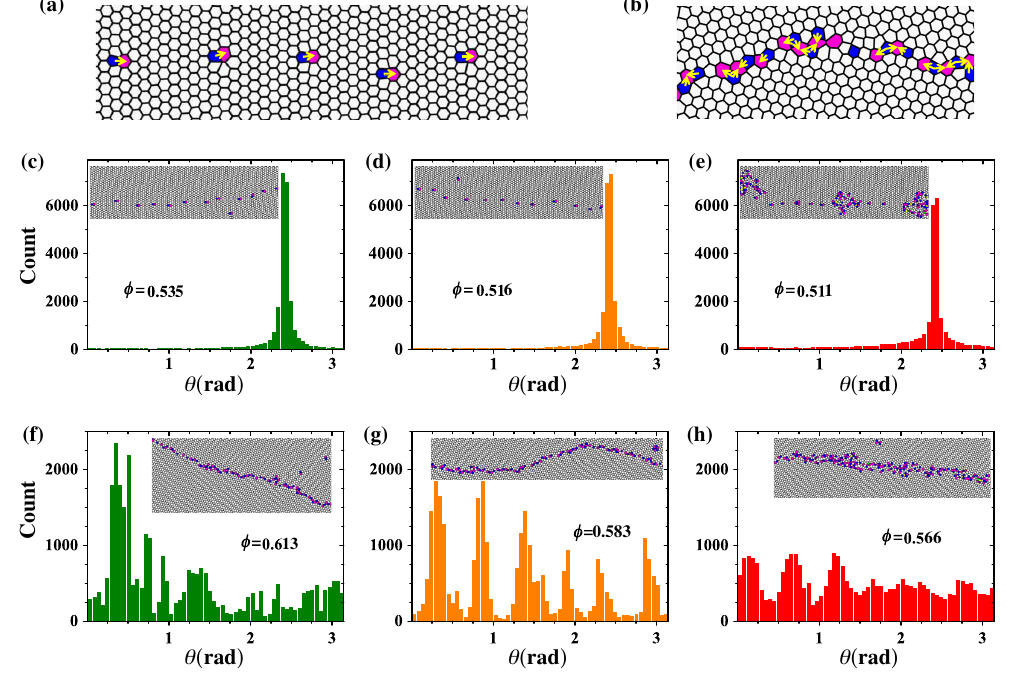
FIG. 10. (a,b) The Voronoi polygons with colored particles without exactly six nearest neighbors. A dislocation is a pair of 5- and 7-neighbor polygons; its orientation, defined as the direction from 5 to 7, is labeled with a yellow arrow. (a, c – e) The θ ¼ 8 ° grain boundary. (b, f – h) The θ ¼ 28 ° grain boundary. (c) – (h) Histograms of the orientations of 5 – 7 pairs in the grain boundaries. The statistics are calculated from 200 frames at each ϕ